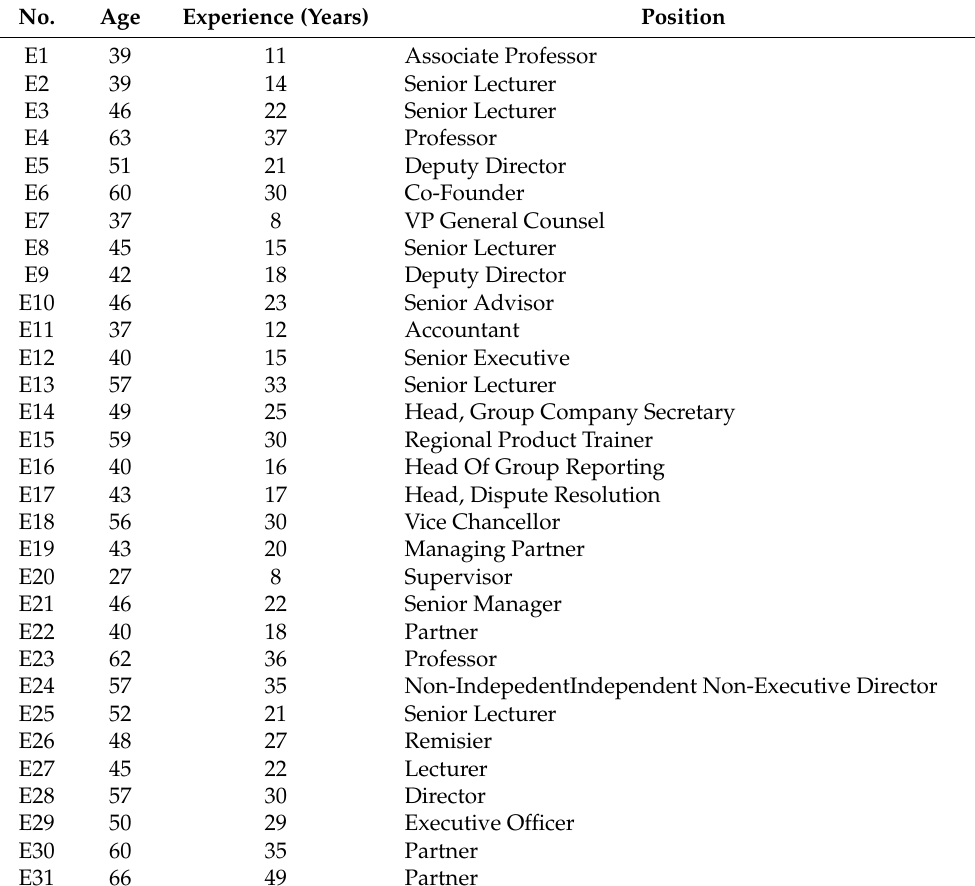
Table 1. Experts Who Participated in the Delphi